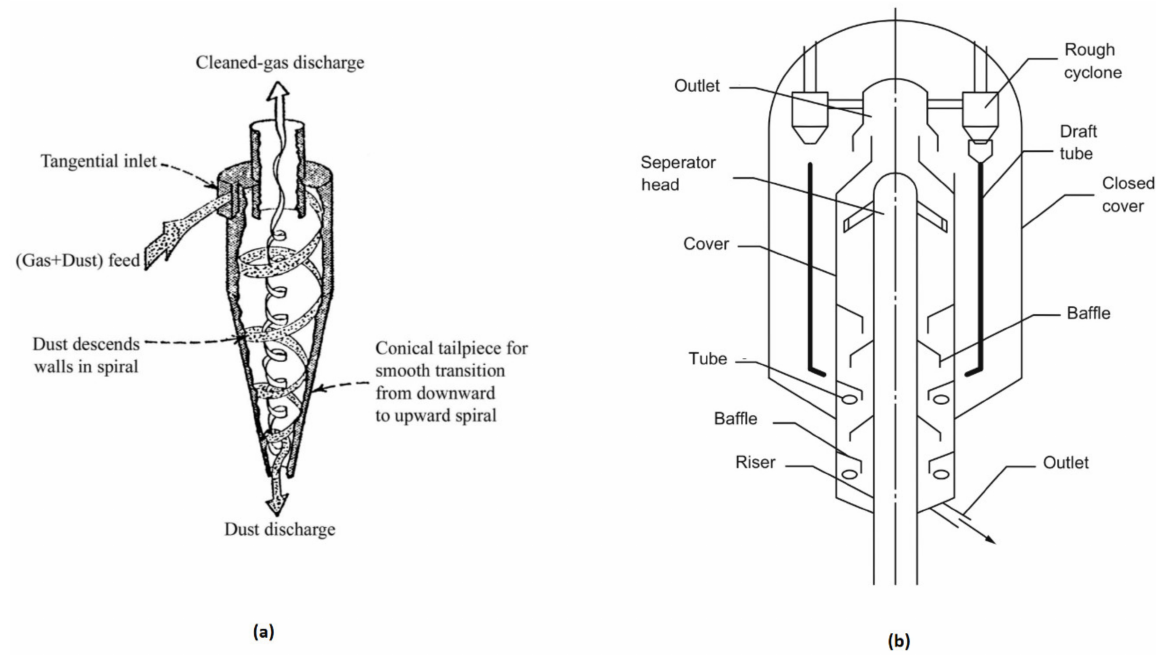
Figure 5. ( a ) vortex flow patterns inside a tangential inlet cyclone [158], ( b ) a basic vortex quick separation showing a multi-cyclone system for FCC reactor termination